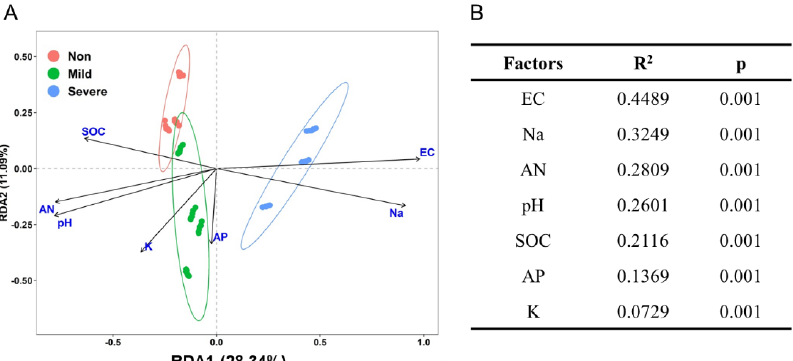
Figure 3. Nonmetric multidimensional scaling (NMDS) plot of bacterial community in the soils with three salinity levels: Non − salinity, Mild − salinity and Severe − salinity. Plot ( A ) depicts the Bray–Curtis distance and PERMANOVA with a global test and pairwise comparison ( B ) shows Bray – Curtis distance − based dissimilarity of the bacterial community in the soils with three salinity levels.